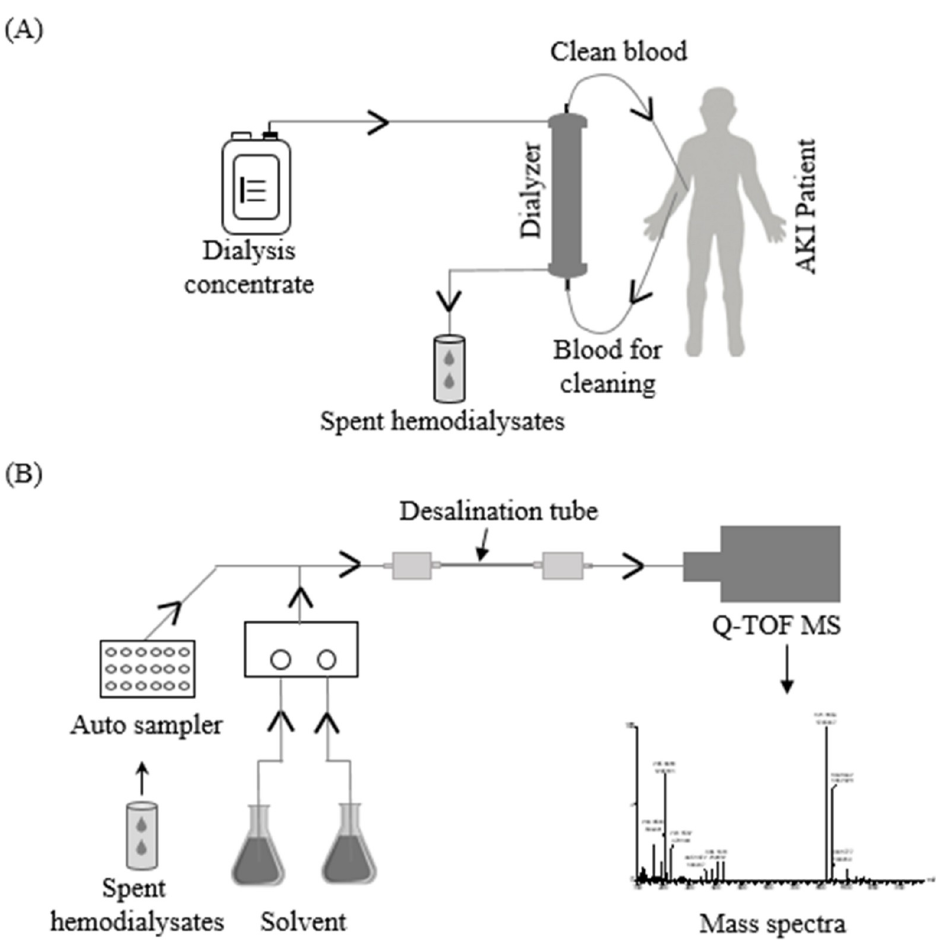
Fig 1. An overview of spent hemodialysate analysis using online desalination tubes. (A) spent hemodialysates were collected from acute kidney injury (AKI) patients and (B) subsequently analyzed by online desalination tube coupled with